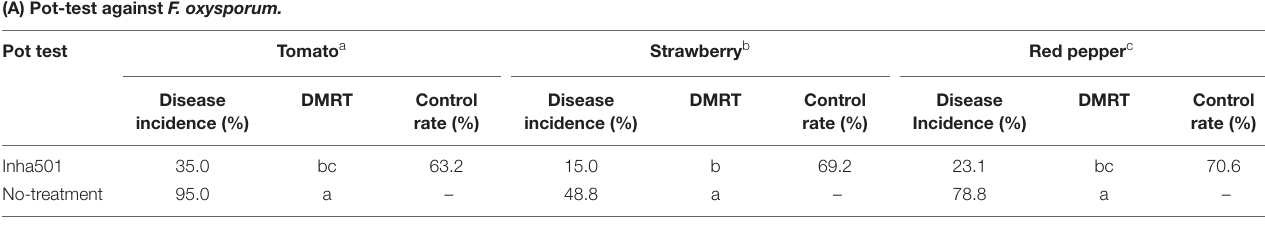
TABLE 1 | In vivo antifungal activity of S. rubrisoli Inha501 against Fusarium wilt. (A) Pot-test against F.